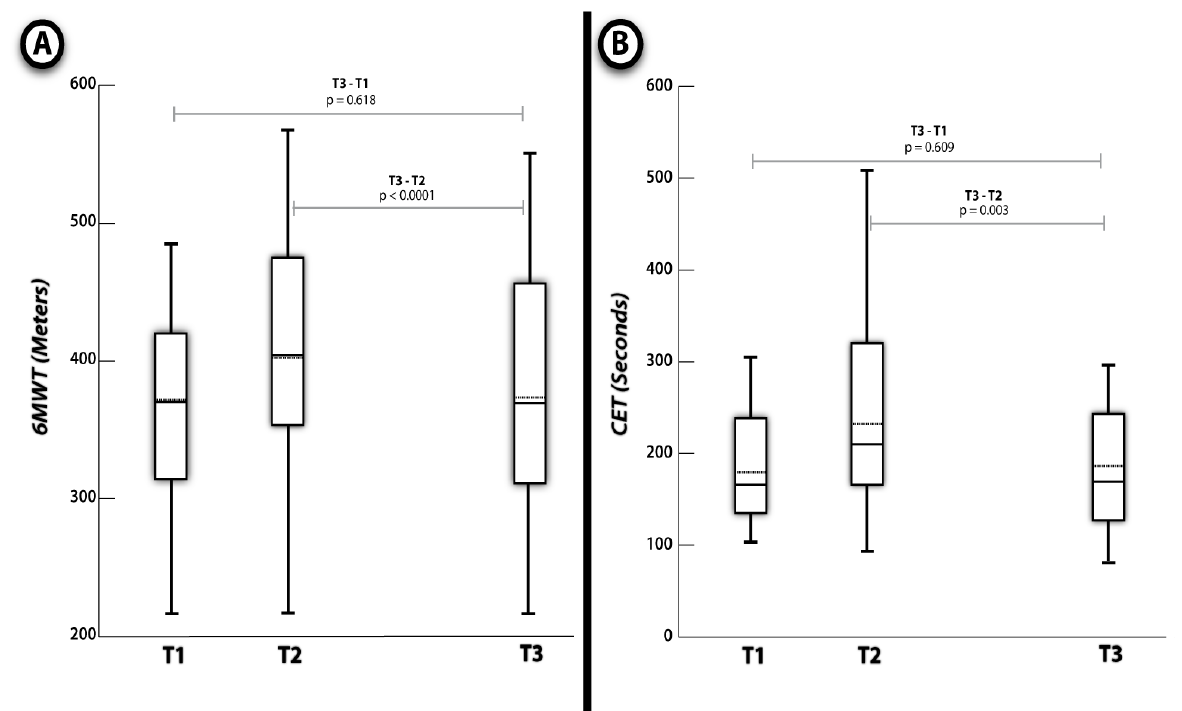
Figure 2. Changes in A. 6MWT, walking distance and B. CET, endurance time immediately after a pulmonary telerehabilitation intervention and 6 months later (gray lines inside the boxes are means, black lines are medians). Quality of life improved significantly after the intervention still present 24 weeks later, with a significant decrease of (T2-T1) for three out of four domains of the CRQ (dyspnea, values and return to baseline performance for each domain fatigue and emotion). However, none of these changes were of the CRQ (Figure